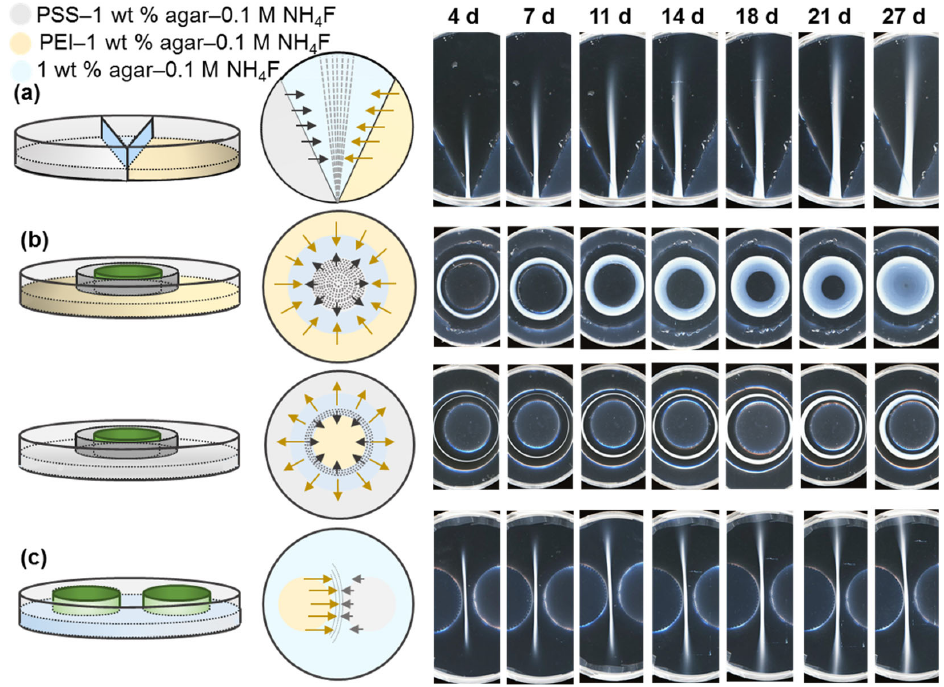
of semicircular coacervate membrane. Figure 2. Experimental setups for the formation of diffusion ‐ controlled spatially distributed PEC from PEI ( c = 2.5 g/L, M w ≈ 25 kDa) and PSS ( c = 2.5 g/L, M w ≈ 70 kDa) in 0.1 M NH 4 F: ( a ) tangential periodic bands (method I) ( b ) radial concentric rings (method II) ( c ) semicircles (method III). The membranes were further formed from polyelectrolytes of different average mo ‐ lecular weights: PEI ( M w ≈ 25 kDa, M w ≈ 750 kDa), PSS ( M w ≈ 70 kDa, M w ≈ 1000 kDa) and various concentrations (1.25 g/L, 2.50 g/L, 5.00 g/L) according to method II . Figure 3 shows typical morphologies of PEI–PSS membranes obtained by diffusion ‐ controlled precipita ‐ tion of high and low molecular weight polymers of different concentrations. The topogra ‐ phy of the central ring zones of the gel film is represented by an array of circular ‐ symmet ‐ ric membranes. Coacervate layers broaden from ca. 0.04 to 1.74 mm with an increase in the concentration of polymers, which follows simple empirical laws typical for Liesegang patterns [7]. The layer width also increases with an increase in the molecular weight of the polyelectrolytes due to the abundance of reactive sites and a higher solution viscosity, slowing down the precipitation (Figures S2 and S3). Figure 3 shows that spatiotemporal precipitation of the membranes is highly regular and follows simple empirical laws typi ‐ cal for Liesegang patterns. Time ‐ lapse analysis of the membrane growth according to method I and method II (Figure S4) shows that the dependence of membrane thickness r n on the precipitation time t n is described by the time law r n ∝(cid:3493)𝑡 (cid:3041) [49] and the mass transfer of the polyelectrolytes within agar gel obeys Fick’s second law (Equation (2)): 𝑑𝐶 𝑑𝑡 (cid:3404) 𝐷 𝑑 (cid:2870) 𝐶 𝑑𝑥 (cid:2870) , (2) where D is a diffusion coefficient, dx is the change in the position of the coacervate band from the solution ‐ gel interface, and (cid:3031)(cid:3004) (cid:3031)(cid:3047) refers to the time gradient of substance concentra ‐ tion. According to Fick’s second law, the rate of subsequent periodic zone formation de ‐ creases as the sequence number of membrane increases.